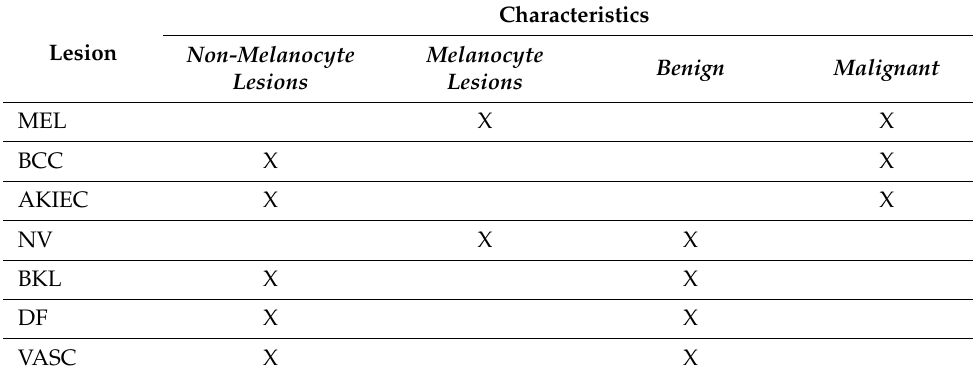
Table 1. Characteristics of